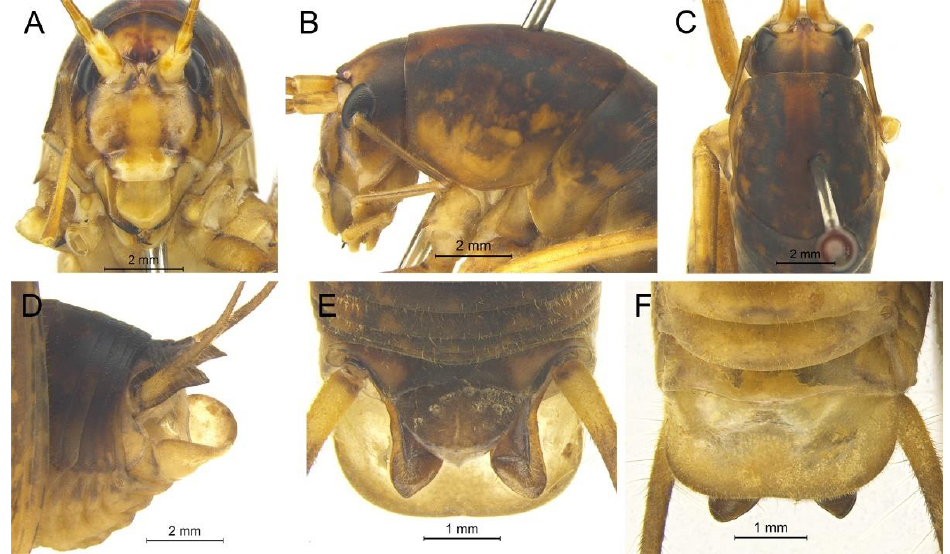
Figure 15. Pseudotachycines fengyangshanensis Zhu & Shi sp. nov., male: ( A – C ) head and pronotum: ( A ) frontal view, ( B ) lateral view, ( C ) dorsal view; ( D – F ) apex of abdomen: ( D ) lateral view, ( E ) dorsal view, ( F ) ventral view.